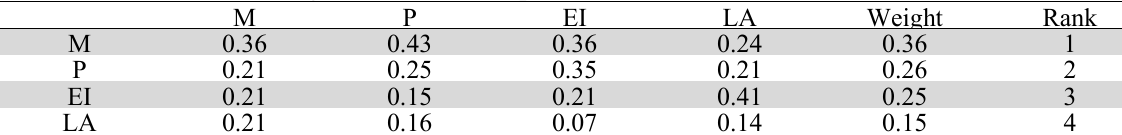
Normalized matrix and weight of criteria (Output) M